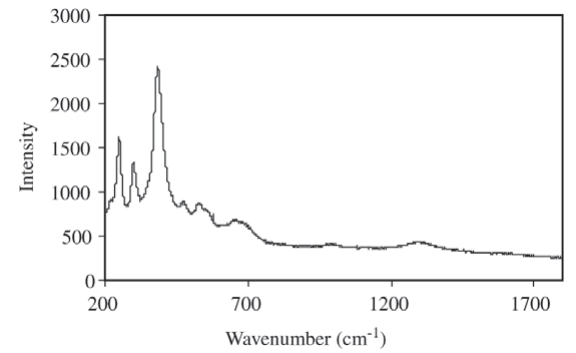
Figure 2. Raman spectrum of a carbon steel specimen exposed for one month at Paula Souza site, showing characteristic peaks of goethite and lepidocrocite from yellow oxide